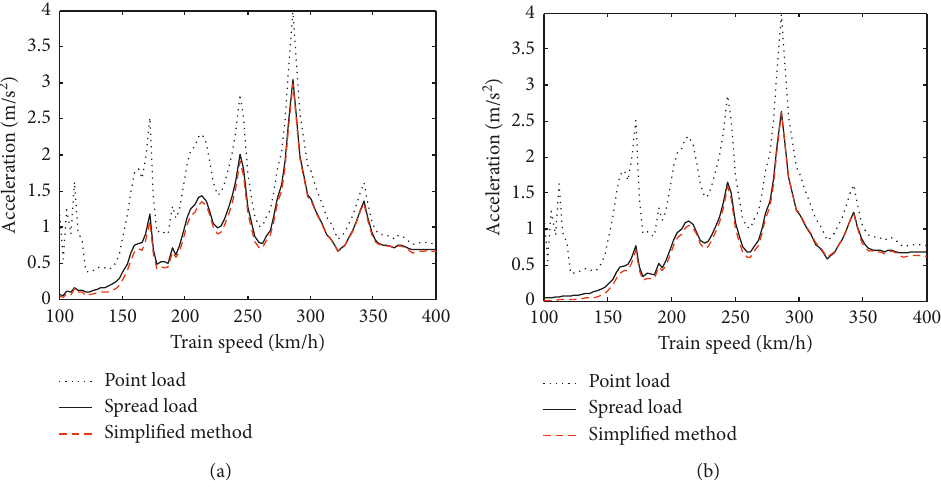
Figure 14: Maximum bridge acceleration (VBI model). (a) EC block load. (b) Triangular load.